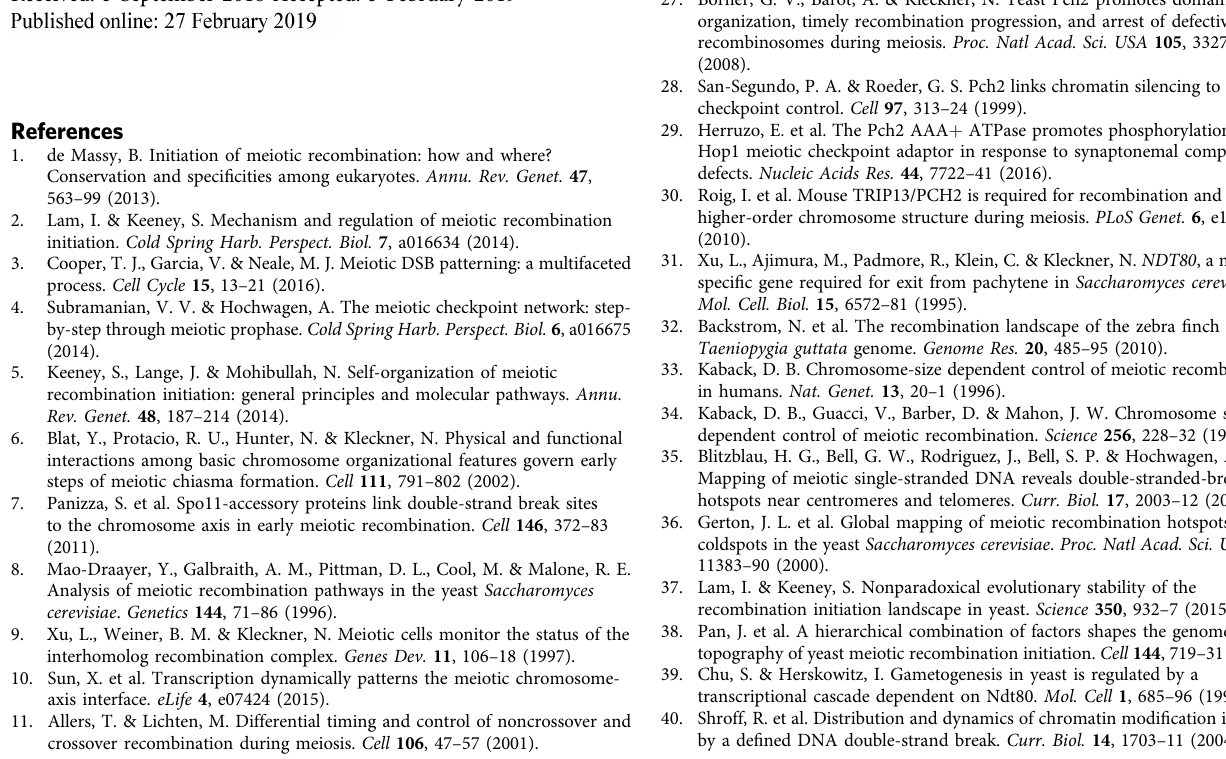
(Supplementary Table 6) for wild-type meiosis, GEO accession number GSE85253, were obtained from ref. 43 . The processed dataset aligned to the S288c reference genome (sacCer2) was used. The mapped Spo11-oligo counts within hotspots for wild type and zip3 Δ mutant, GEO number GSE48299, aligned to the S288c reference genome (sacCer2) were obtained from ref. 16 . Wild type datasets from GEO dataset GSE67910 44 were used as control for Spo11-Flag oligo sequencing data from pch2 Δ and sir2 Δ